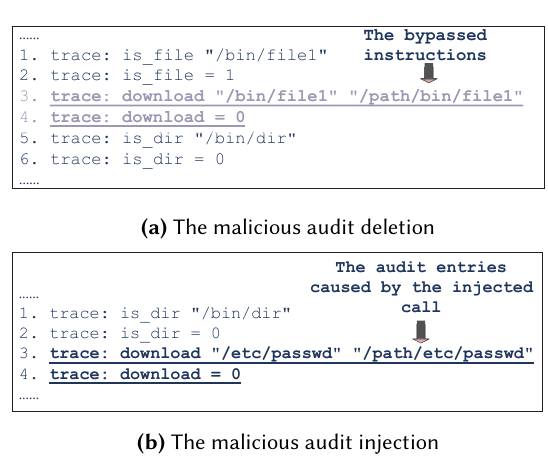
Figure 2. Malicious Audit